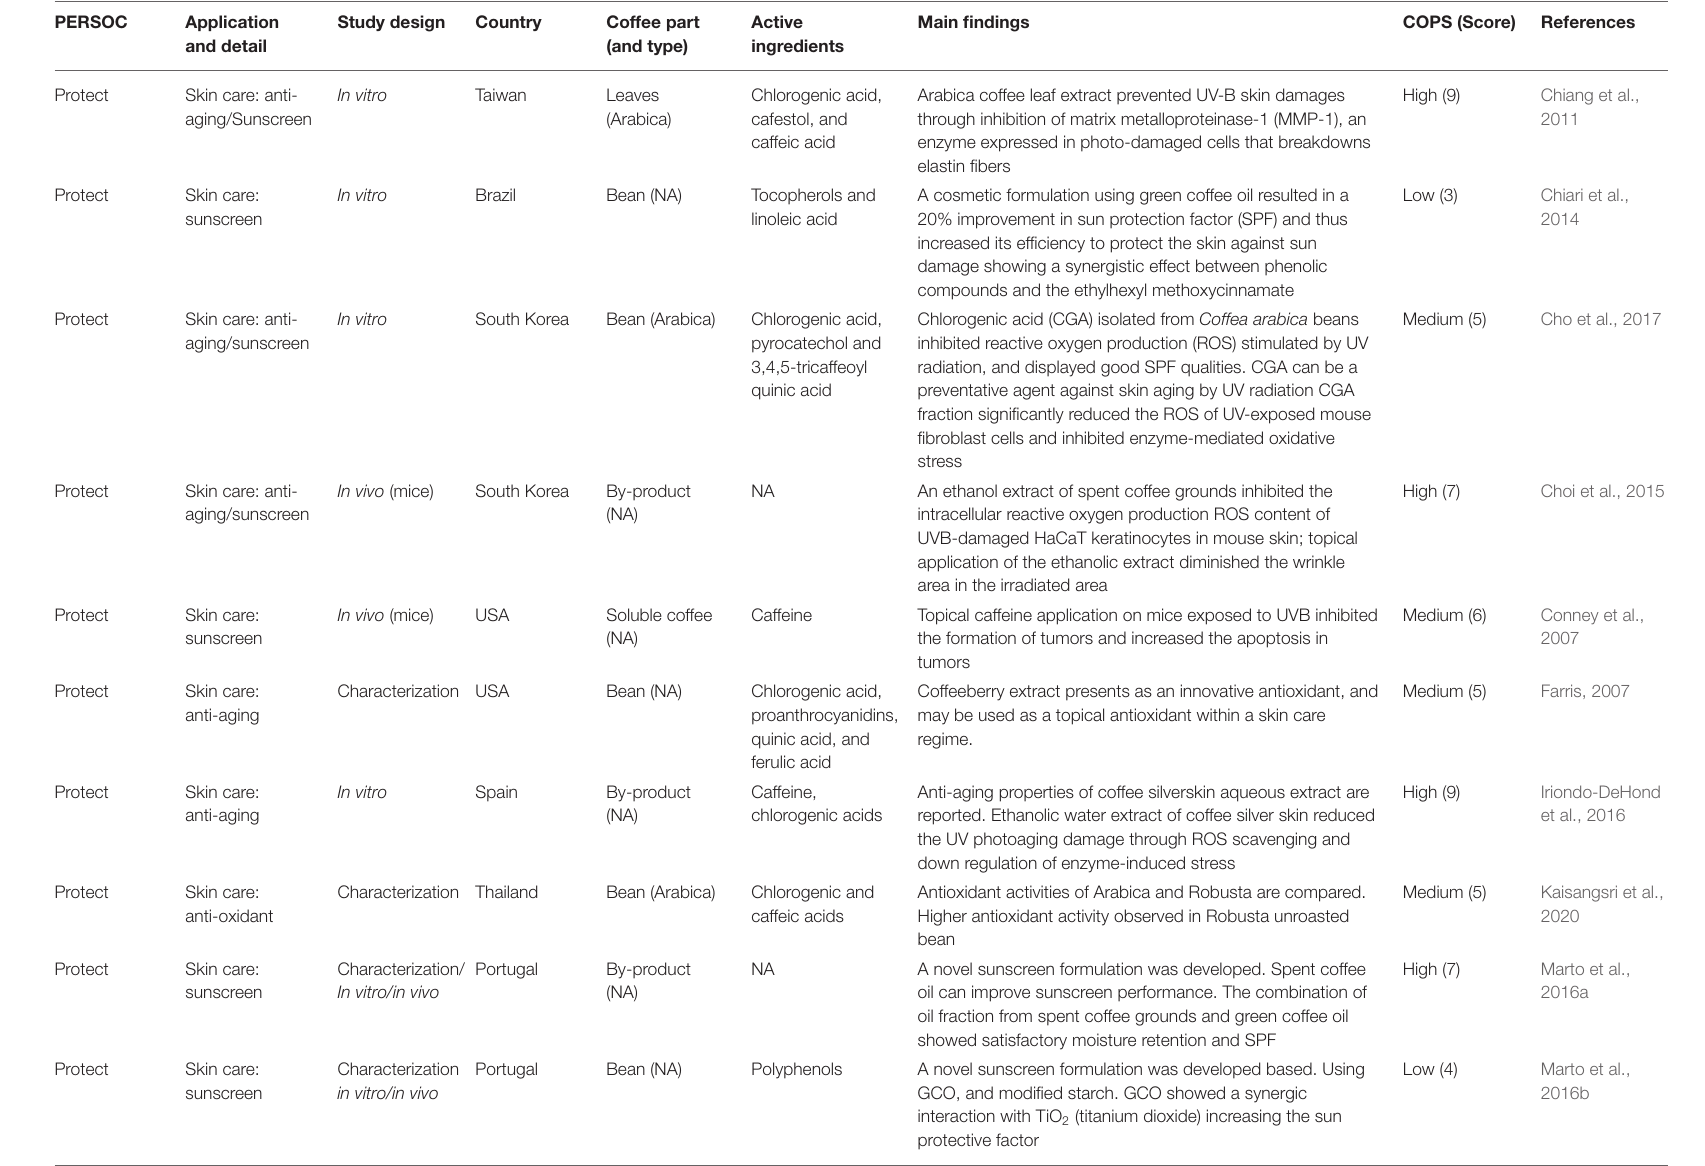
TABLE 3 | Data extraction and COPS classification of the 14 papers classified according to PERSOC where “Protect” is perceived as the dominant aim.